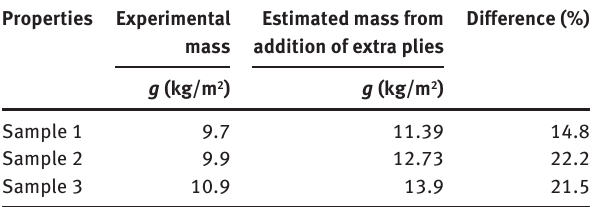
Table 4 Comparison of experimental and estimated mass (using traditional design approach) under measured